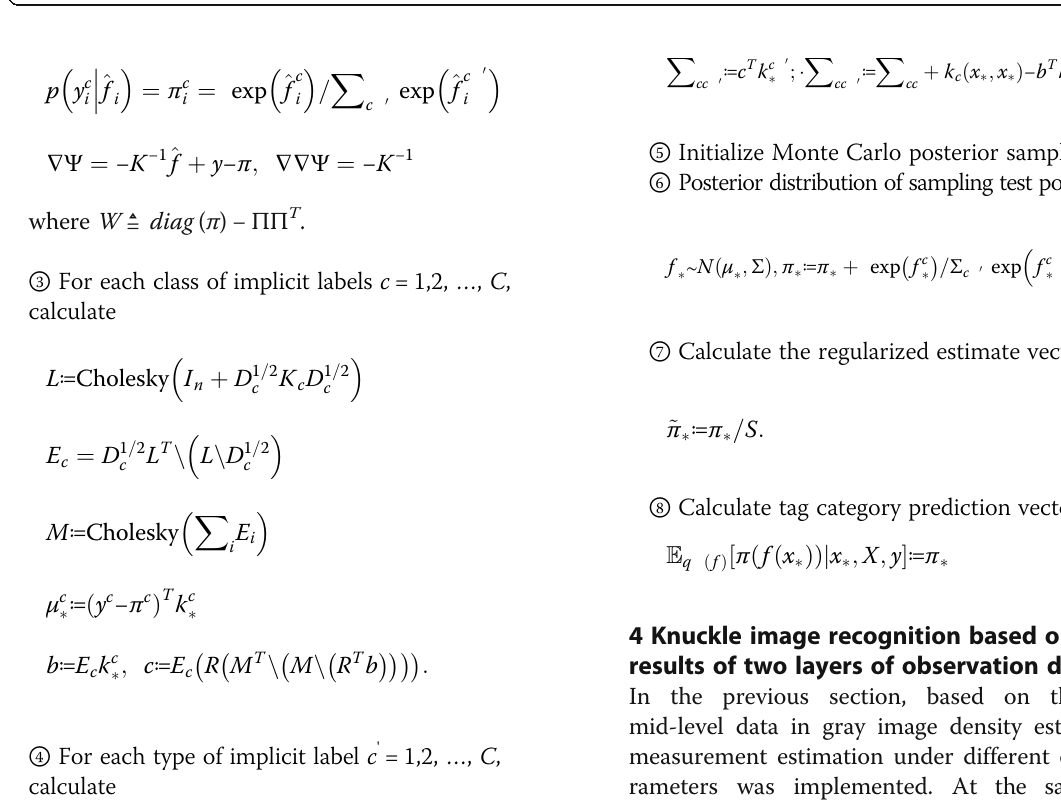
Fig. 3 Covariance matrix of GP learning on middle-layer data from knuckle image. a Covariance matrix on GCP model on far knuckles 1 and 2. b Covariance matrix on GCP Model on middle knuckles 1 and